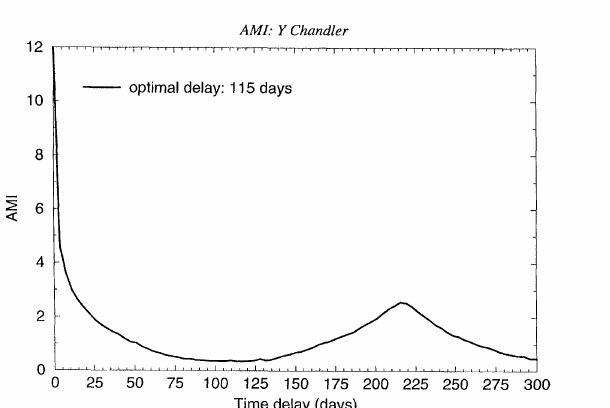
FIGURE 2 AMI as a function of the time-delay T. The delay r for data embedding corresponds to the first minimum of the AMI